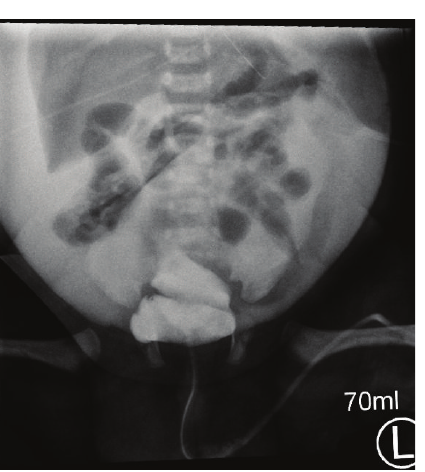
Figure 1: Massive abdominal ascites in neonate prior to exploratory laparotomy.